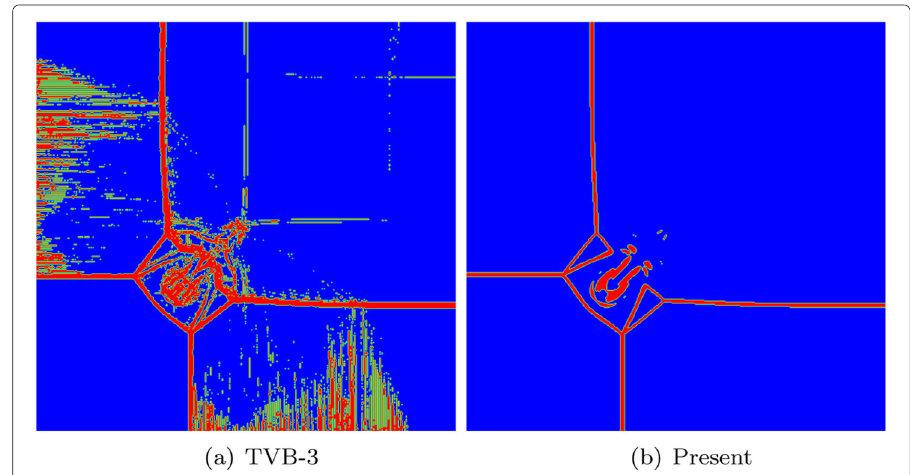
Fig. 5 Troubled-cells flagged by various indicators in the Riemann problem case for 2D Euler equations with grid at T=0.3 under RKDG(p2) framework S − 1 400